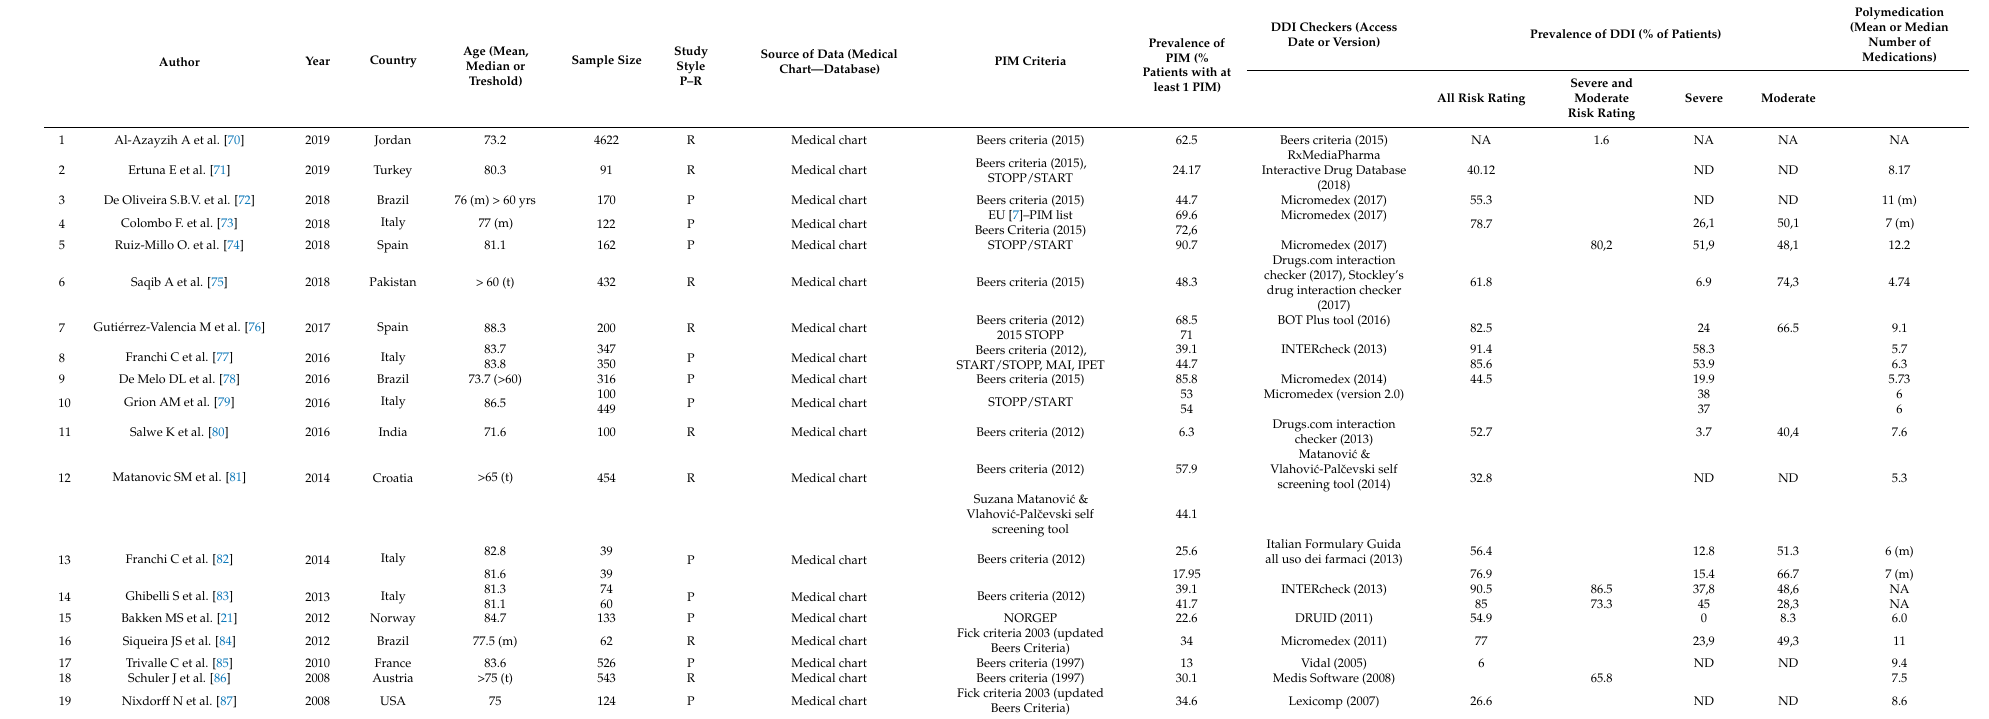
Table 3. Prevalence (%) of PIM and DDI (total, severe and moderate) and polymedication (mean or median) in elderly patients in hospital setting. At the end of the table, the prevalence of PIM and of DDI is reported as the weighted mean (in bold). Footnote: Prospective (P), retrospective (R), mean (M), median (m), threshold (t), severe (S), moderate (M), not apply (NA), not determined